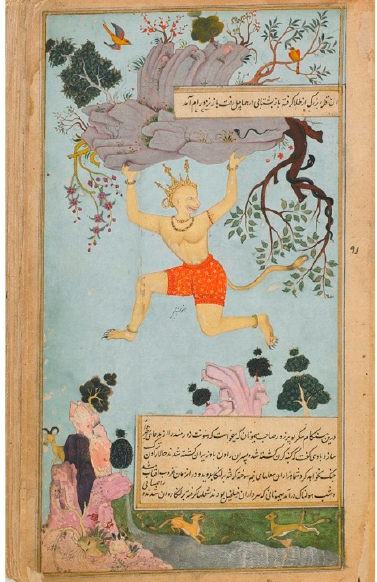
Figure 2. Folio from the Freer Ramayana , 1597–1605, Mughal India, ink, opaque water color and gold on paper. Freer Gallery of Art, Smithsonian Institution, Washington, D.C.: Gift of Charles Lang Freer,